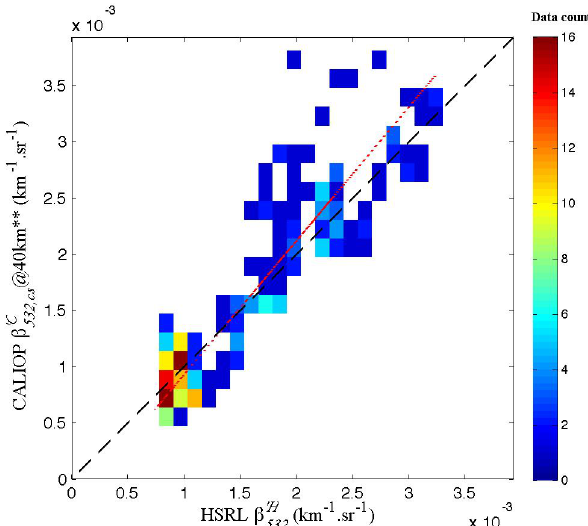
0 H (red profile in Fig. 5) 532 ∗∗ 0 C = (1.19 ± 0.03) 532 ,CS